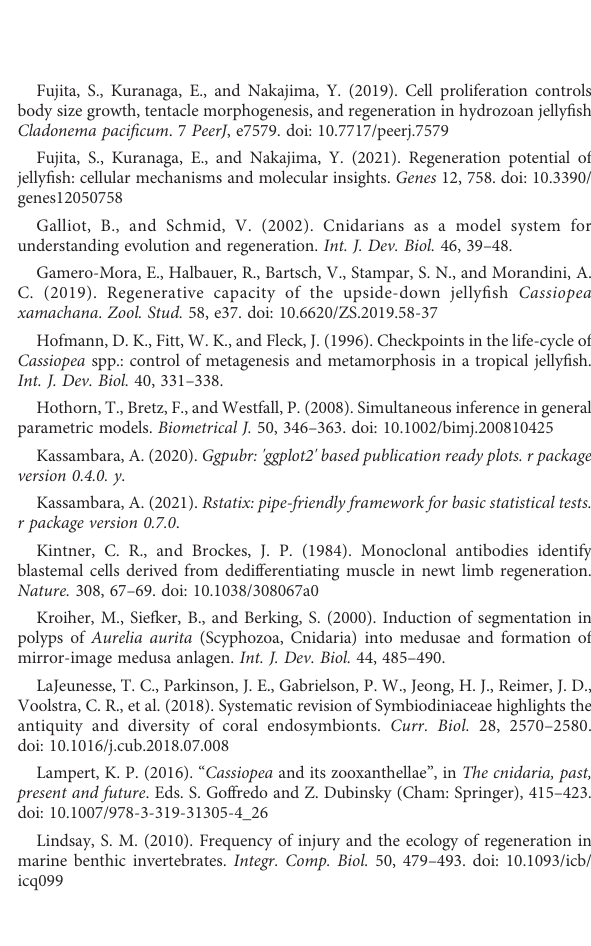
SUPPLEMENTARY TABLE 4 Umbrella